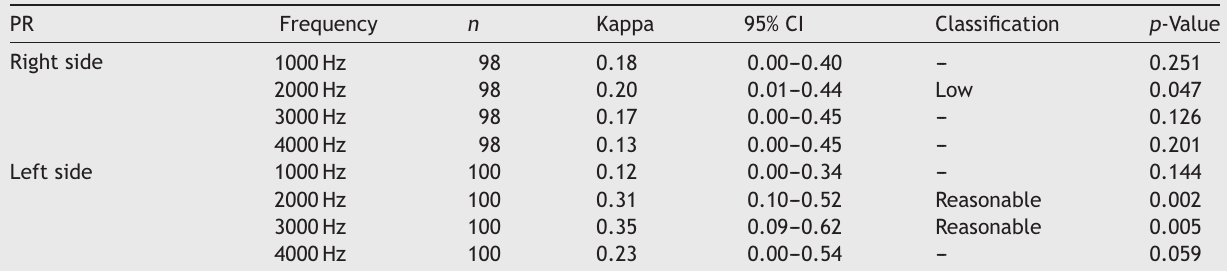
Kappa coefficient for agreement amongst TOAE, tympanometry, and PR tests in 105 newborns evaluated.